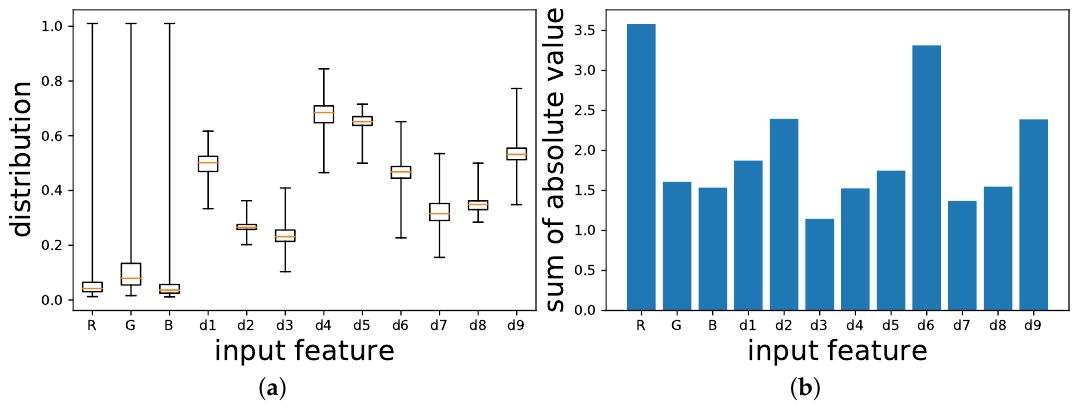
Figure 6. ( a ) The boxplot of the distribution of the input tensor of test dataset for OF-CRM ( η = 0.001, 4.470). ( b ) Sum of absolute value of all kernels for the input features of a segmentation module in OF-CRM ( η = 0.001, 4.470). R channel and d 2 = R / ( R + G + B ) , d 6 = B / ( B + R ) , and d 9 = R / ( B + R ) are more important than the other features and